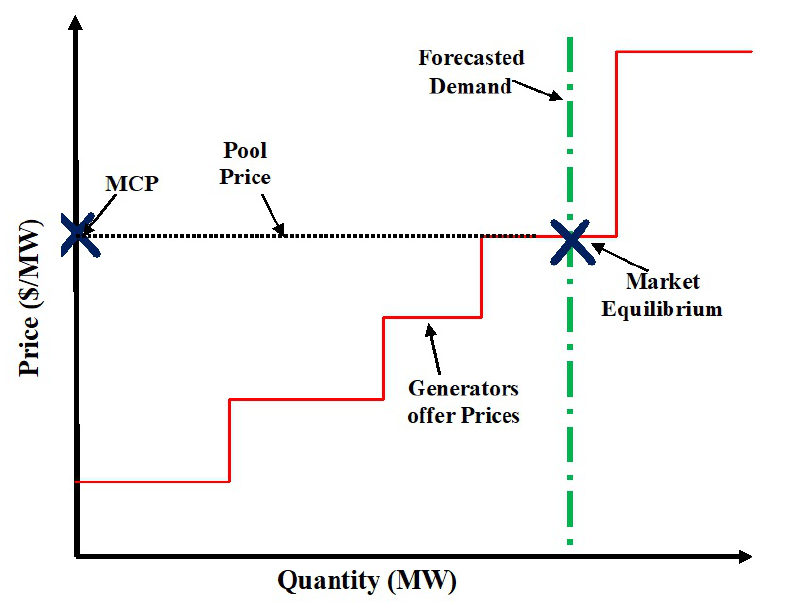
Figure 3. Supplier side’s bidding